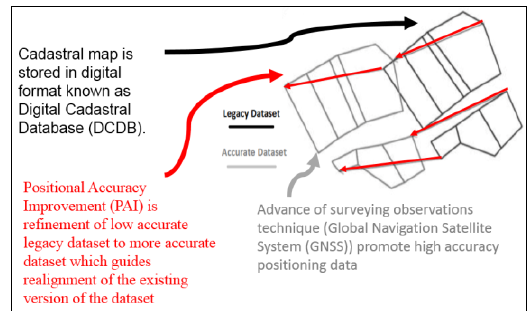
Figure 1. PAI concept (Norshahrizan et al.,